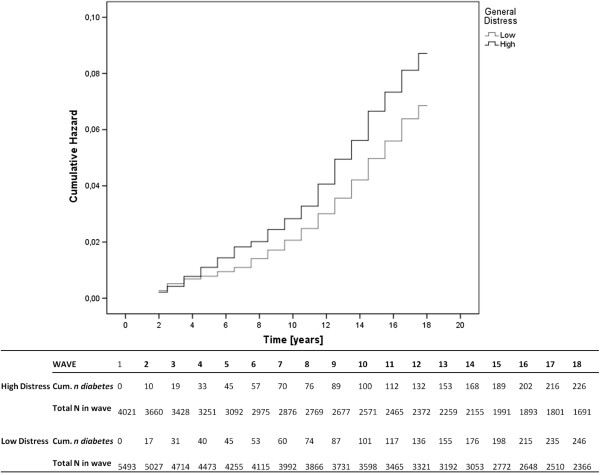
Cumulative hazard of diabetes stratified by general psychological distress.